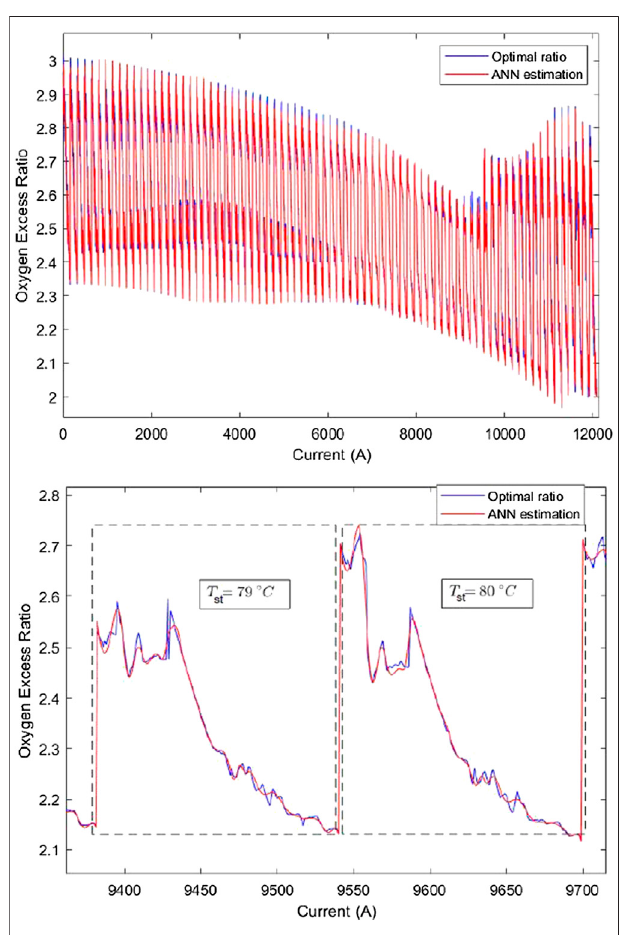
FIGURE 9 | Optimal OER and its estimation using ANN. The curves are combined for different temperatures.